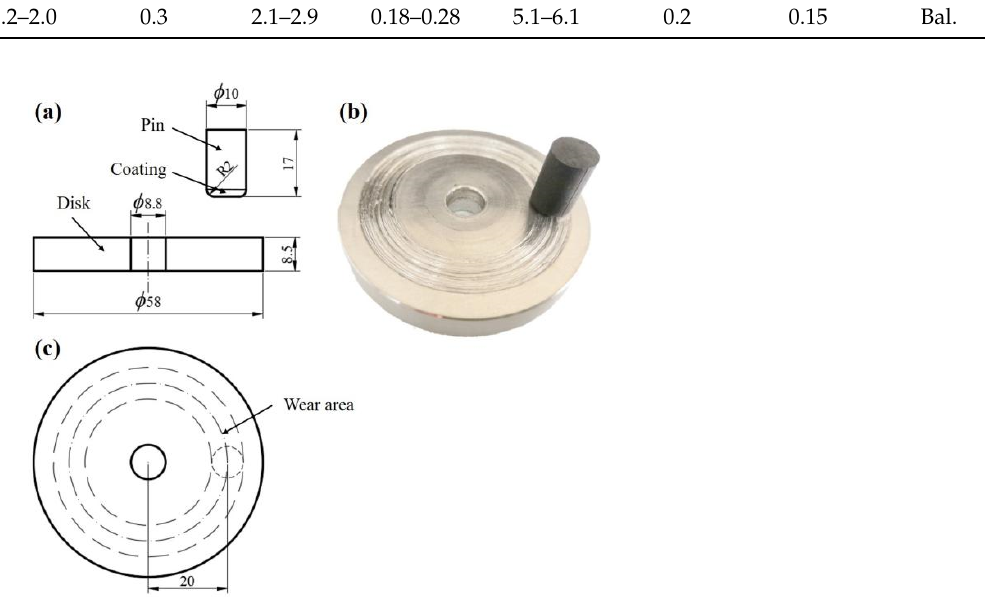
Figure 5. Sample diagram of pin-on-disc wear test: ( a ) dimensions of pin and disc (mm); ( b ) contact diagram of pin and disc; ( c ) schematic diagram of the wear area. Table 3. Chemical composition of Al-7075 (wt.%).